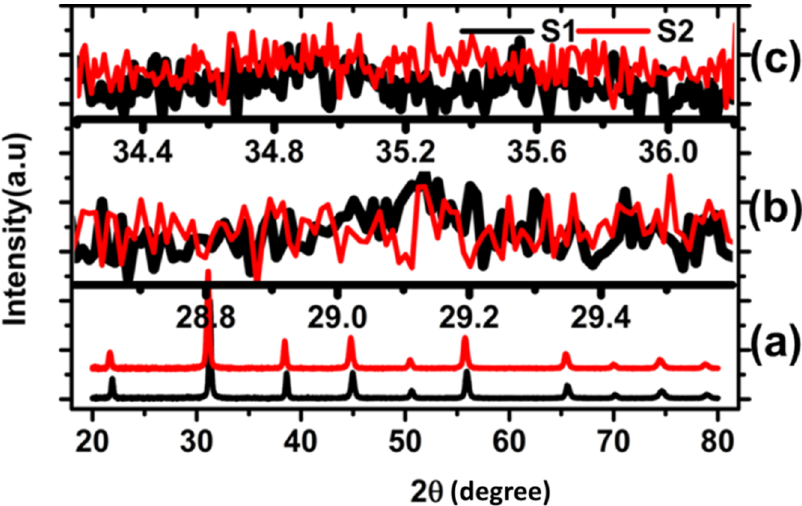
Figure 4. XRD diffraction data of oxidized CSNP that were synthesized from low (s1) and high (s2) initial concentration of FeCl 3 · 6H 2 O. ( a ) Bragg peak from crystalline BaTiO 3 , references were shifted in vertical scale, ( b ) zoomed in near (220) peak of maghemite, and ( c ) zoomed in near (311) peak of maghemite.